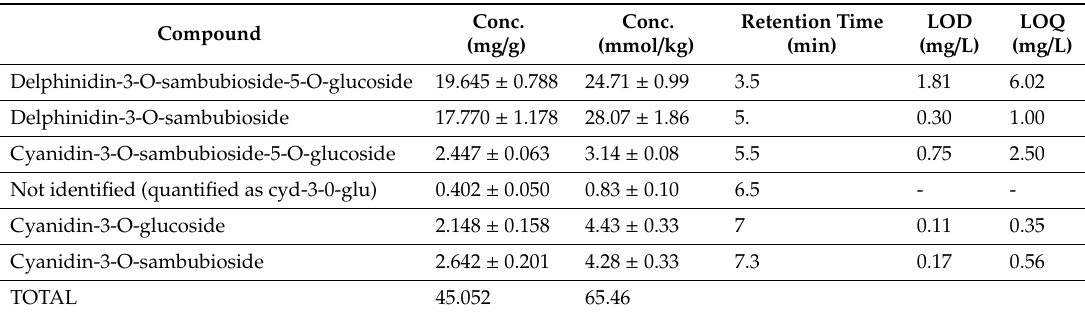
Table 1. Anthocyanidin composition of the lyophilized maqui berry. Anthocyanins were determined by UPLC-DAD. The table shows the concentration in mg / g and mmol / kg of the di ff erent anthocyanidins detected. The table includes the retention time (min), the limit of detection (LOD) and the limit of quantification (LOQ) for each molecule.